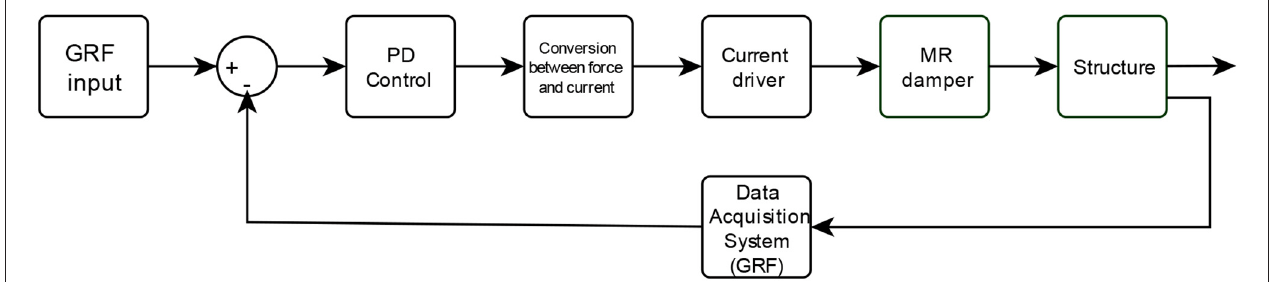
FIGURE 7 | Block diagram of the designed control